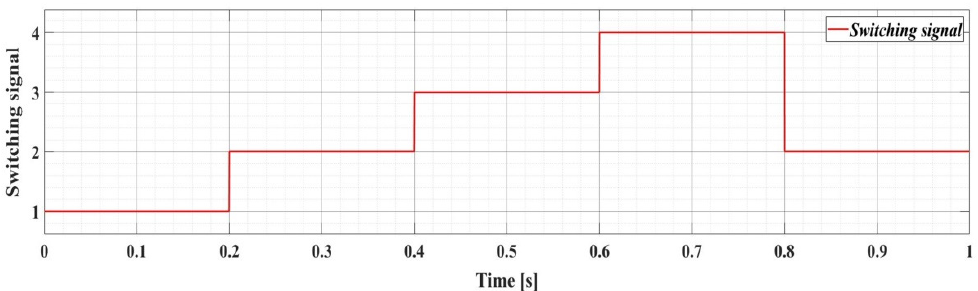
Figure 22. Switching signal type 2.